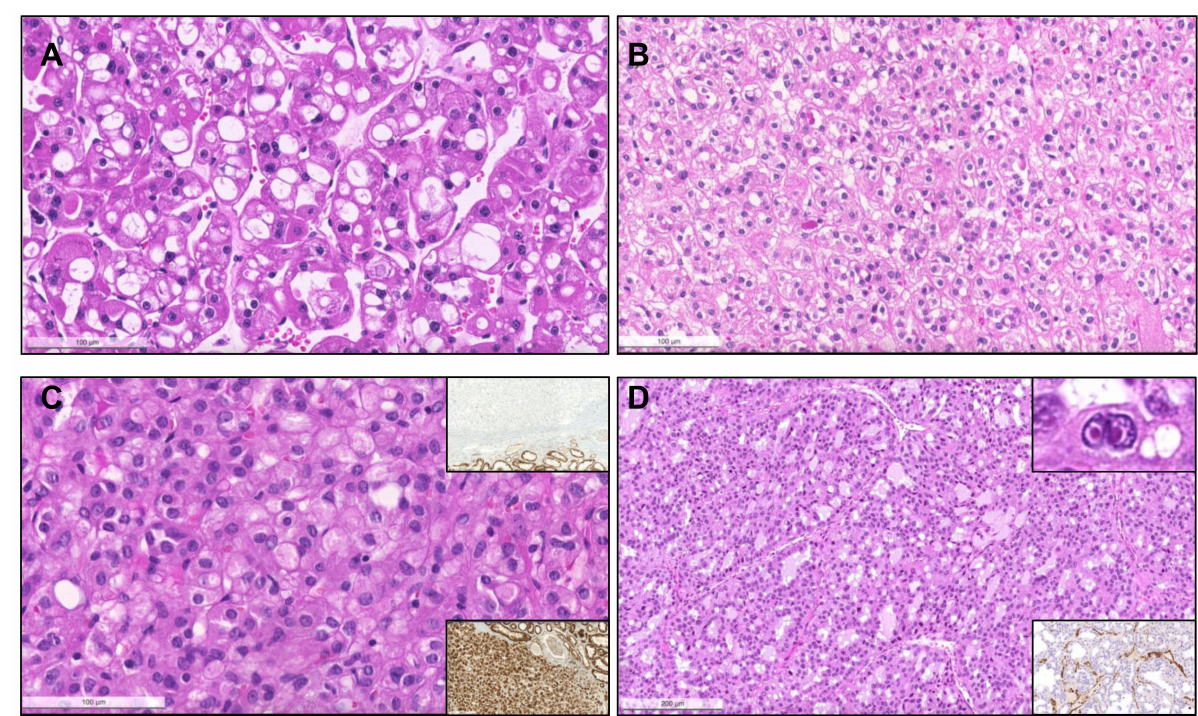
Figure 9. Eosinophilic vacuolated tumor of the kidney. The tumor is composed of cells arranged in small nests and cords, with eosinophilic cytoplasm and round nuclei with prominent nucleoli resembling oncocytoma, but the cytoplasm of tumor cells is remarkably vacuolated (small and large clear vacuoles) along the whole tumor ( A ). Succinate dehydrogenase deficient renal cell carcinoma. The tumor is classically composed of tubules and nests of mostly eosinophilic cells, with flocculent cytoplasm ( B ) and with vacuoles containing clear or slightly eosinophilic fluid, giving a bubbly appearance ( C ), but any morphology may be seen, including rare papillary features. The diagnosis is confirmed by the loss of expression of SDHB, with internal positive control in the adjacent renal tubules (inset, top right). Notice that SDHA expression is retained (inset, bottom right). Fumarate hydratase deficient renal cell carcinoma. The tumor showed a mixture of patterns, with solid, tubular, cystic and papillary areas ( D ). Several tumor cells presented the typical eosinophilic cytoplasm, round nuclei with prominent eosinophilic nucleoli surrounded by a clear halo (inset, top right), and showed the loss of cytoplasmic granular expression of fumarate hydratase in tumor cells (retained in infiltrating lymphocytes and in stromal vessels, inset, bottom